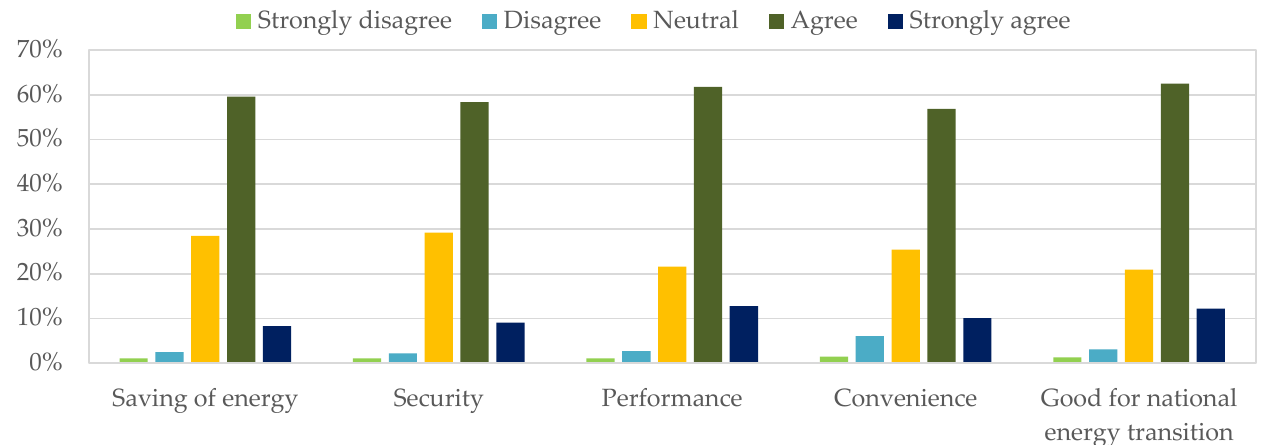
Figure 3. Consumers’ perceptions about the advantages of HPWHs.